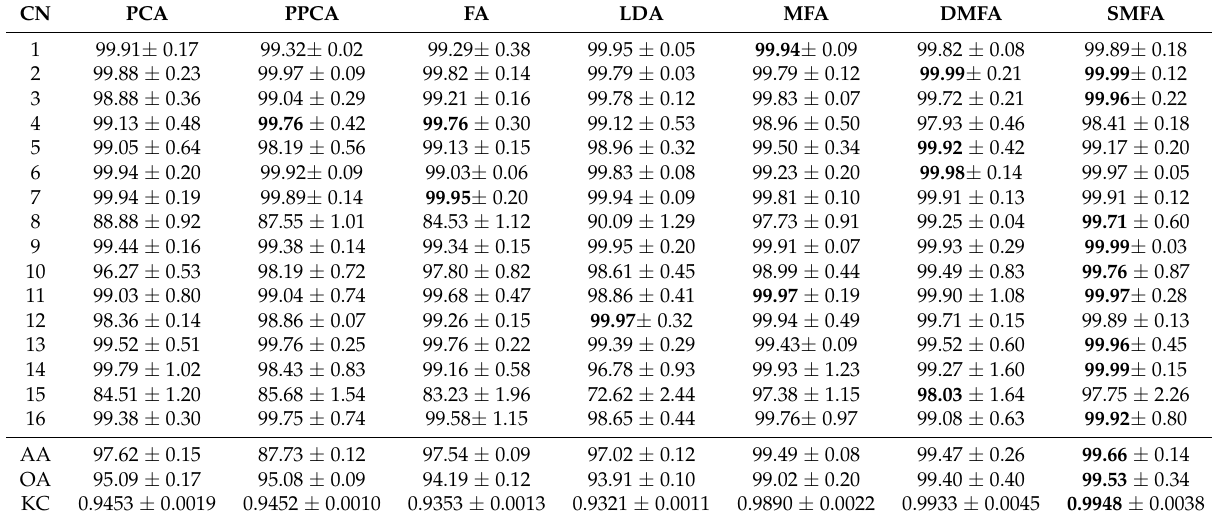
Table 9. The classification results (%) of different DR methods on the Salinas dataset, the best results are in bold typeface. The row of each class number (CN) is the mean accuracy ± standard deviation based on ten